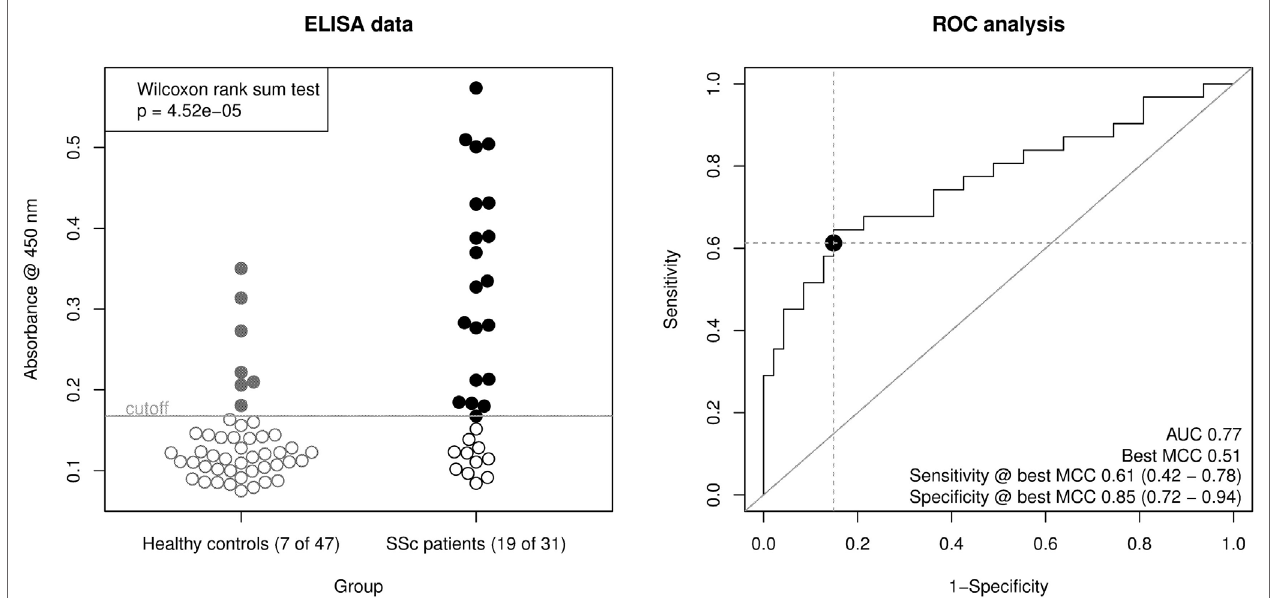
FigUre 3 | Derivation of a mixed-peptide ELISA for the discrimination of SSc patients and healthy controls. Peptides 17, 24, 25, 33, and 34 were mixed for coating of ELISA plates. In total, 32 SSc patient sera and 47 healthy control sera were measured. Left panel, scatter plot of raw ELISA readout values (OD @ 450 nm) including a cut-off value optimized by maximization of Matthew’s correlation coefficient. SSc patient showed a significantly higher ELISA signal than healthy control sera (Wilcoxon rank sum testing p = 4.52 × 10 − 5 ). Right panel, receiver operator characteristic (ROC) analysis of ELISA values. AUC (area under curve, 0.77) and best MCC (Matthew’s correlation coefficient, 0.51) as well as Sensitivity (0.61) and Specificity (0.85) at the optimal cut-off are shown as performance indicators. The dot indicates the optimal cut-off position in the ROC